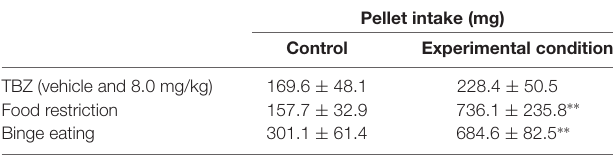
TABLE 2 | Effect of tetrabenazine (TBZ) and behavioral manipulations that increased food value on pellets consumed in the